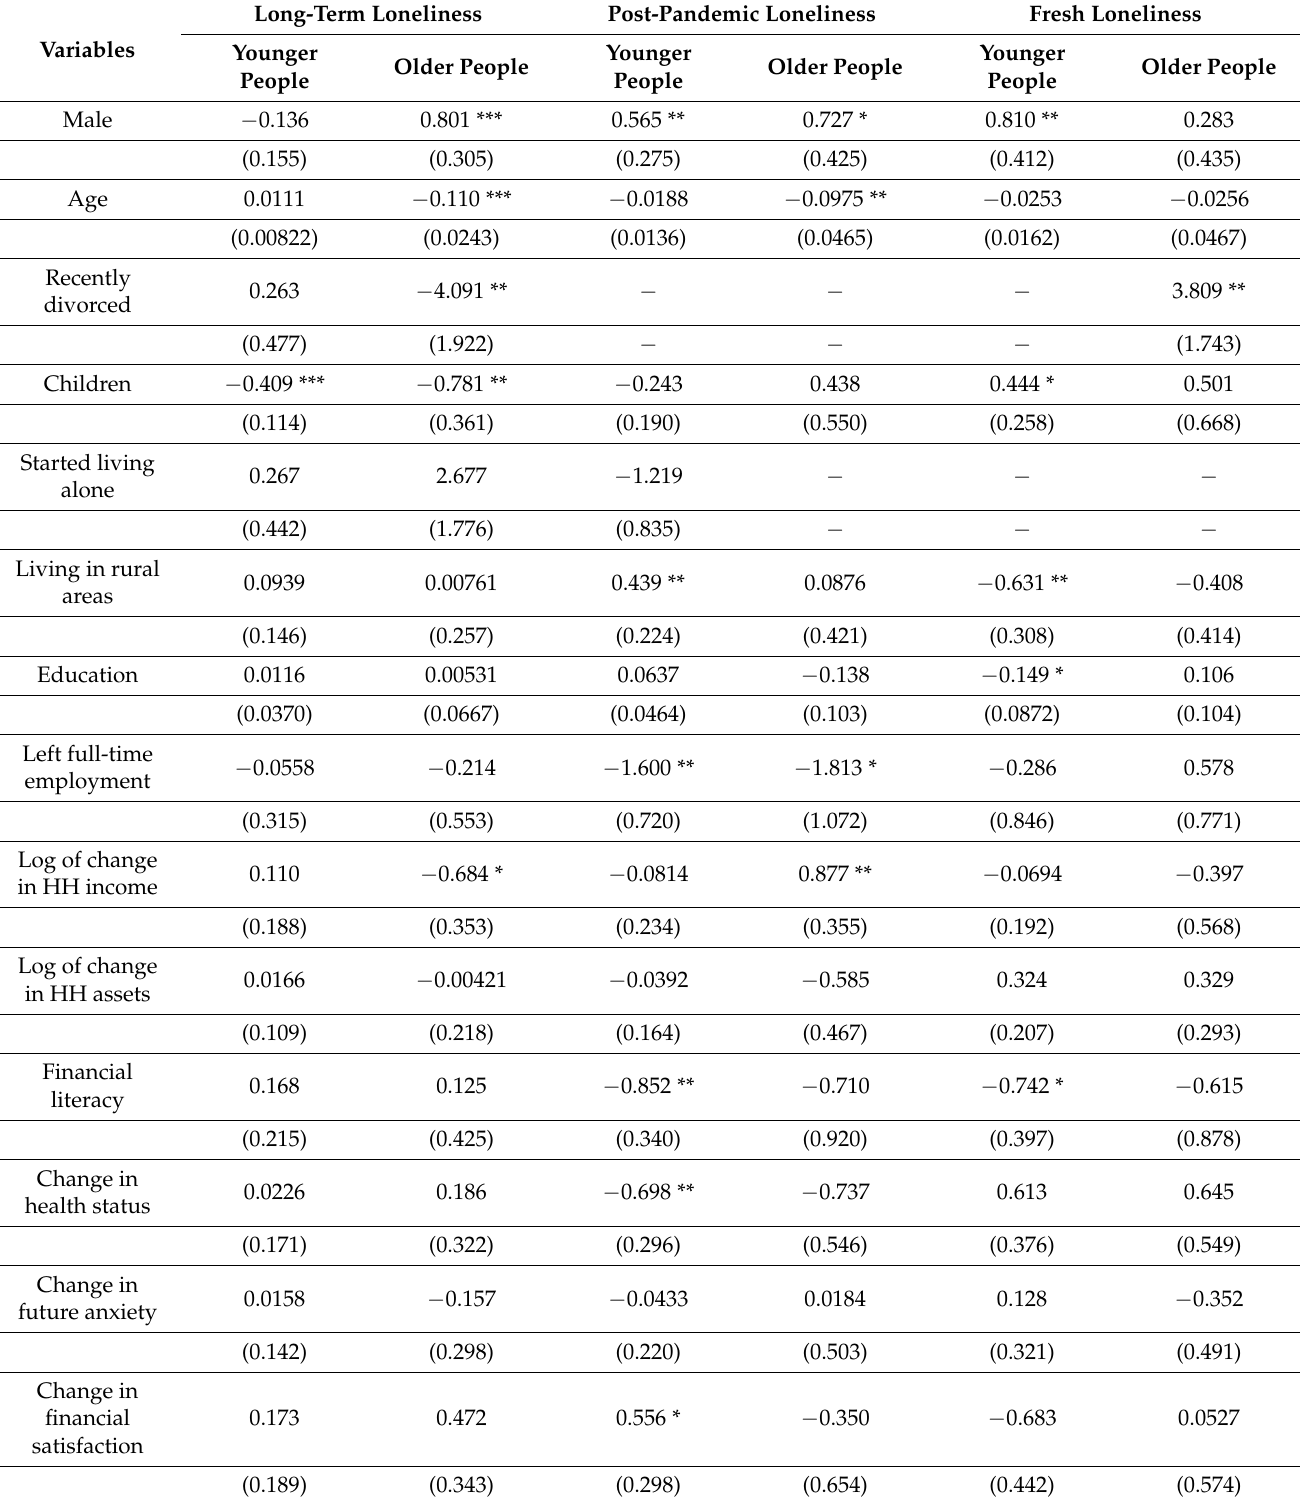
Table 8. Regression results for long-term, post-pandemic, and fresh loneliness, stratified by age